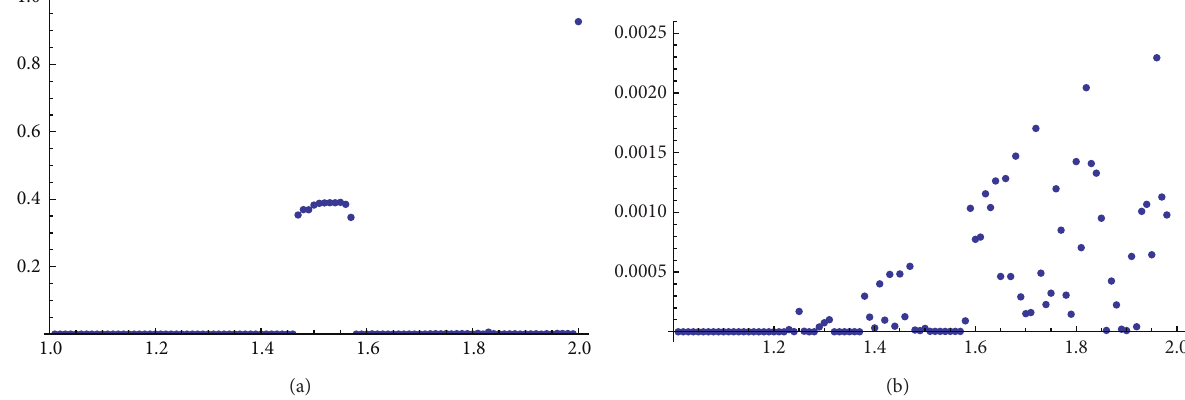
Figure 9: (a) We compute (27) for samples of length 𝑛 = 100000 , 𝛼 = 1.3 , 1 < 𝛽 ≤ 2 , and constant step size ℎ = 0.01 for 𝛽 . We see that (27) is clearly positive when 𝛽 is in a neighborhood of 1.5 . (b) We do the same when 𝛼 = 1.35 , but now we cannot conclude clearly the existence of different